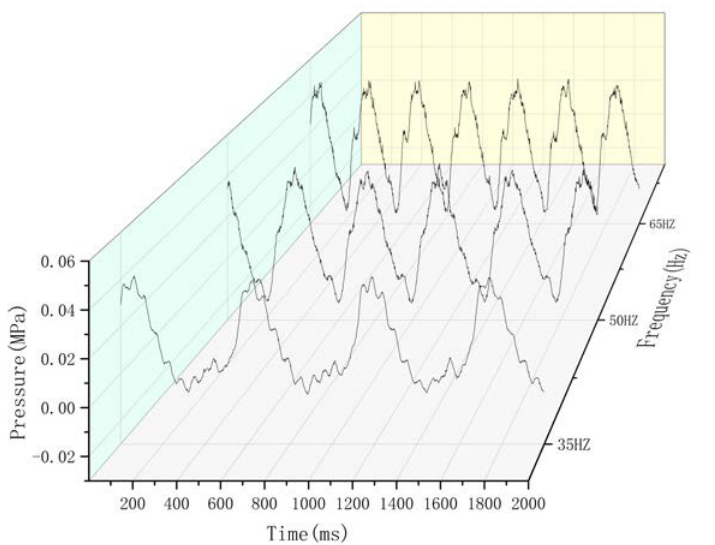
Figure 14. Pulsating pressure experimental results at different speeds with an outlet pressure of 0 MPa.